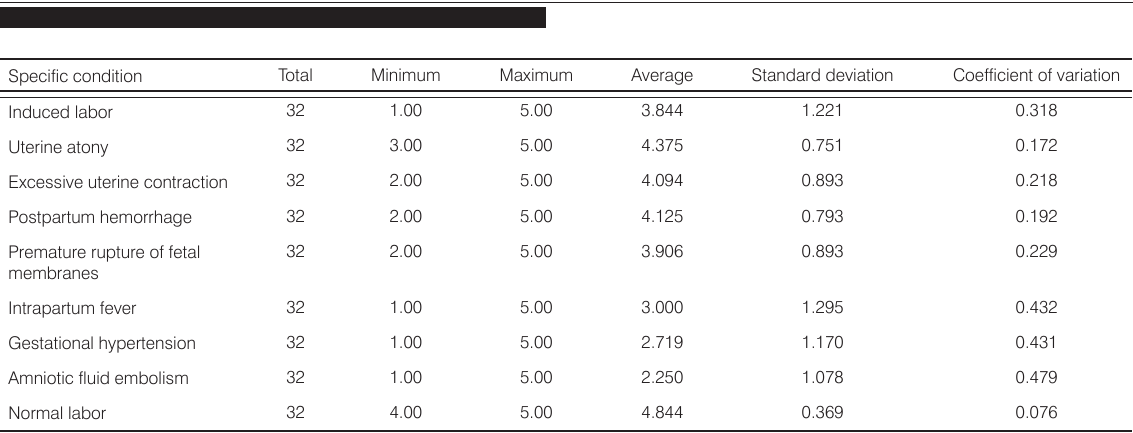
Table 10. Statistics on the acceptance of conditions for midwives practicing prescriptive authority (Round